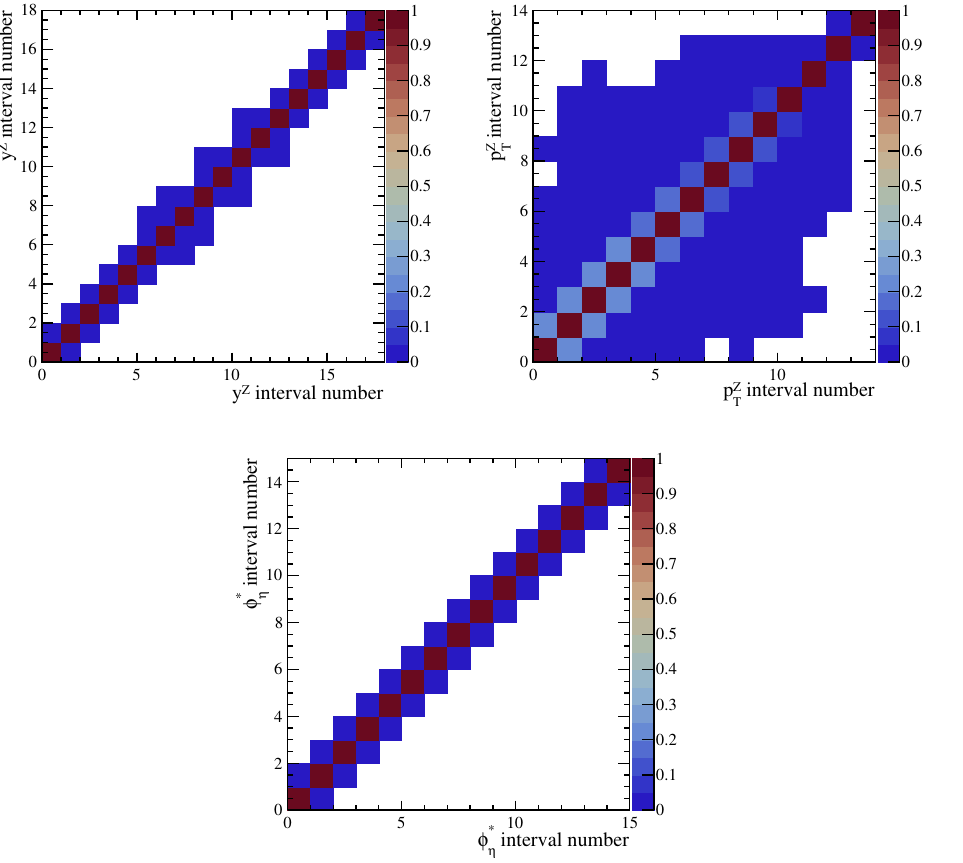
Figure 12 . Statistical correlation matrix of the cross-section measurements in one-dimensional interval regions of (top-left) y Z , (top-right) p Z number’ can be found from table 14 and table 16.